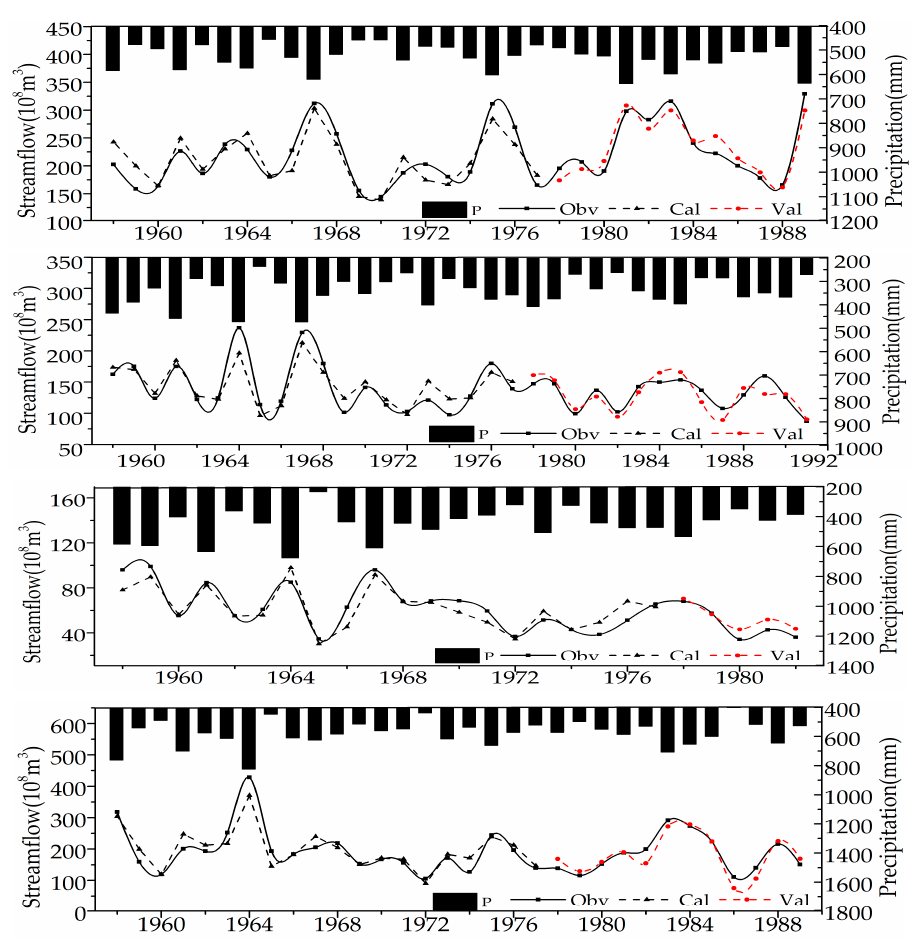
Figure 6. Observed and simulated annual streamflow in four regions during calibration and validation period.